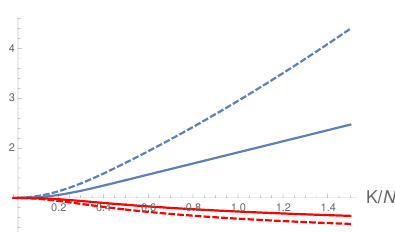
Figure 6. Ratio between geometric quantities at the left end of Σ , Re( z ) = −∞ , in the 3d defect duals (3.3), (3.9) and the BCFT dual (2.8). The blue (red) curves show the ratio of the Ricci scalars (AdS 4 radii f 4 ). The solid (dashed) curves are for Einstein (string)